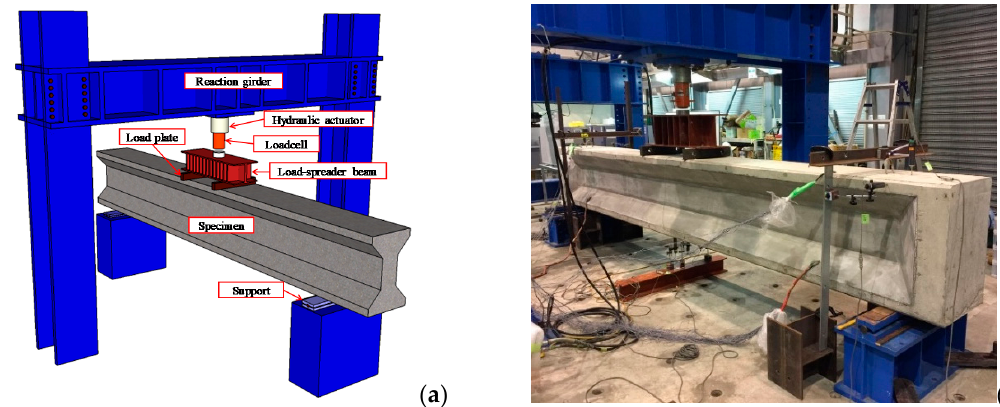
Figure 4. Test setup: ( a ) Schematic diagram; ( b ) Photo.